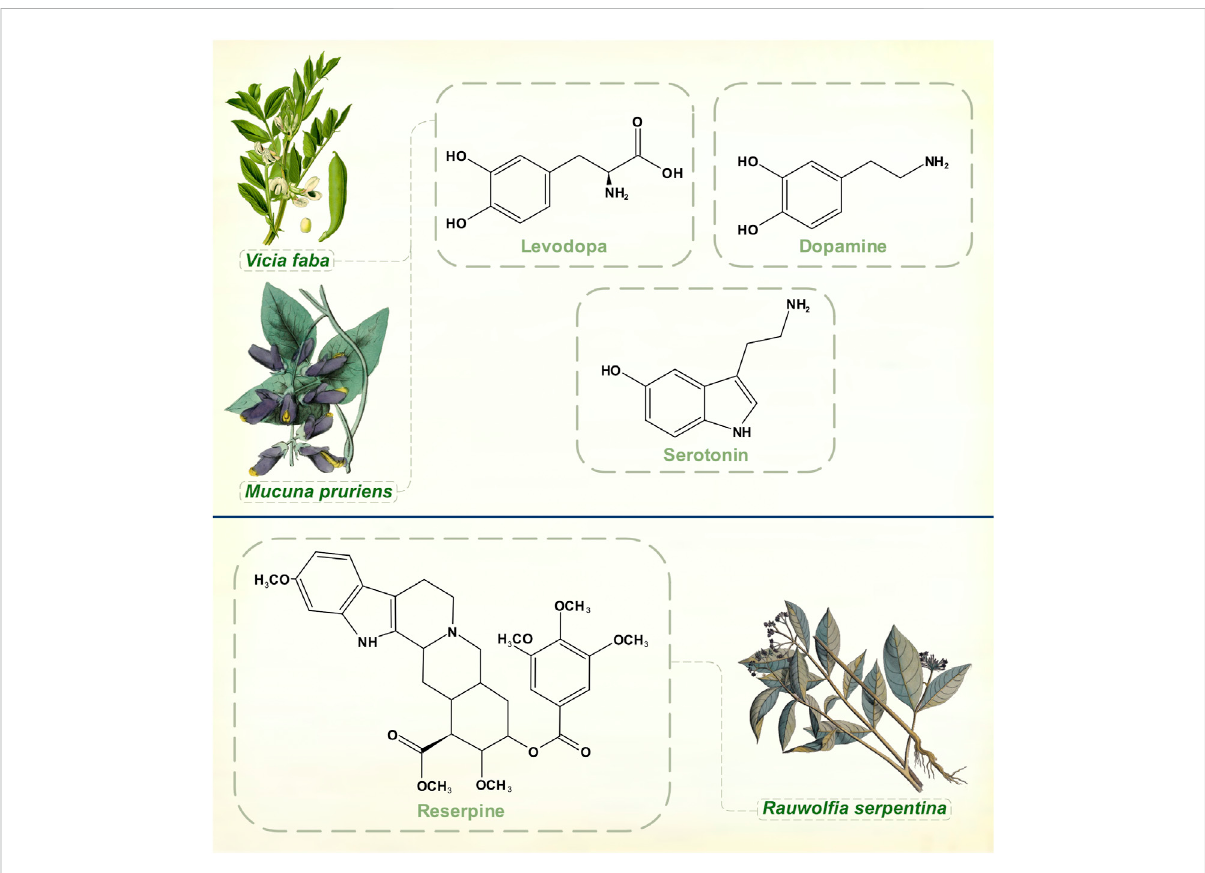
Dopamine, levodopa and serotonin. Experiments with reserpine, an irreversible inhibitor of vesicular monoamine transporters 1 and 2, played a key role in discoveries about monoamine neurochemistry. [Illustrations adapted from Van Rheede tot Drakenstein (1686), Thomé (1885) and Strong (1855b), all available in the public